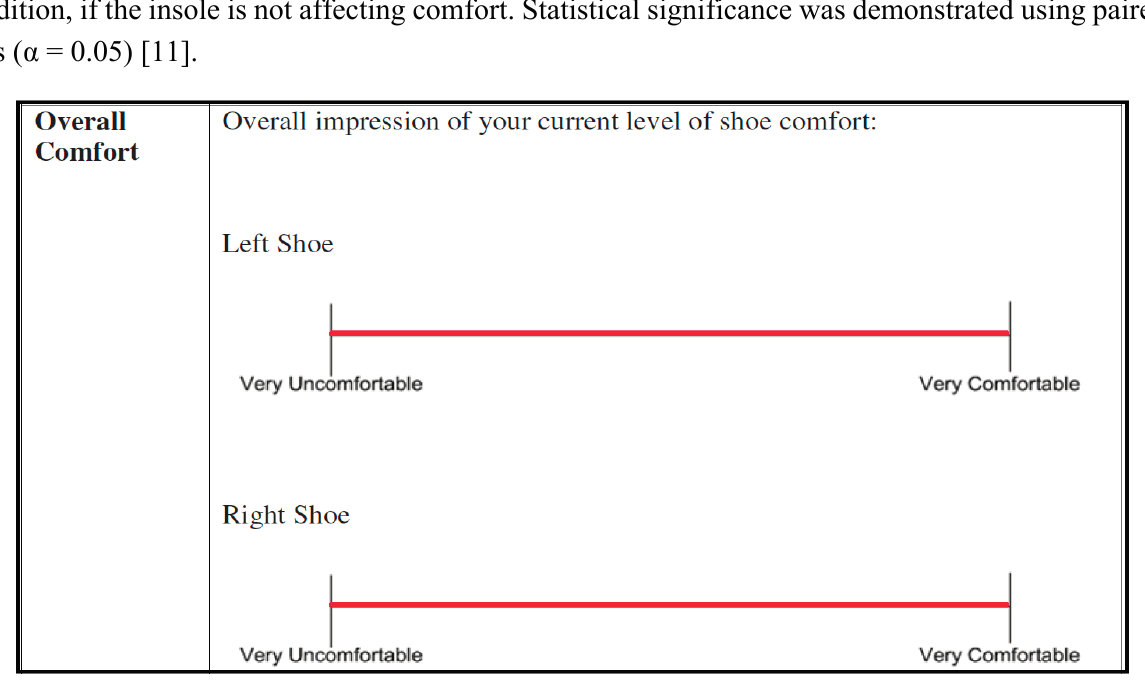
Figure 6. Example of the visual analogue scales used during user testing. Participants marked with an X or a vertical line along the scale where they perceived their current level of